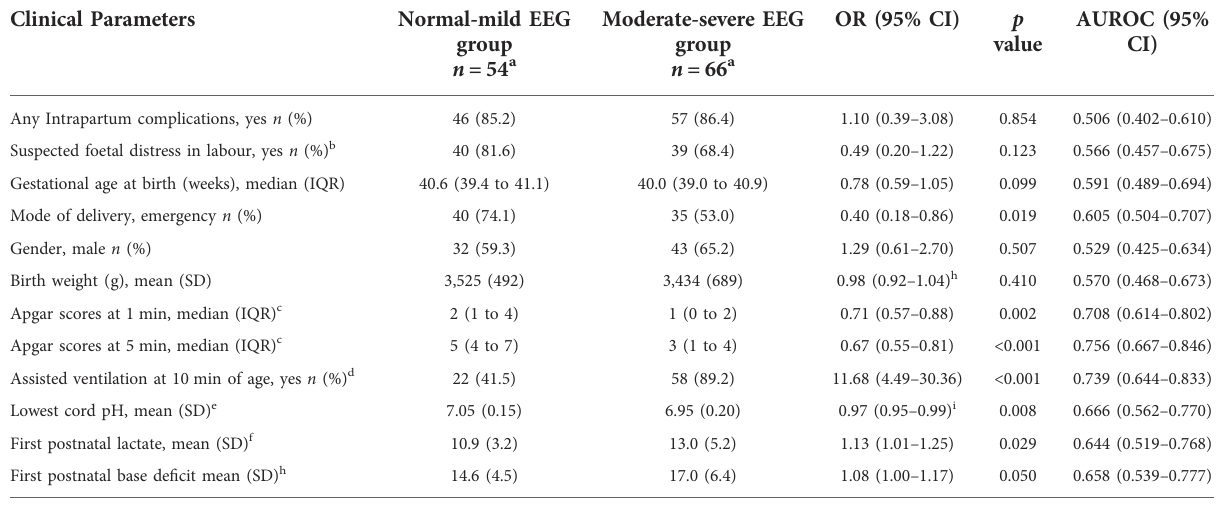
TABLE 3 Clinical univariable analysis.